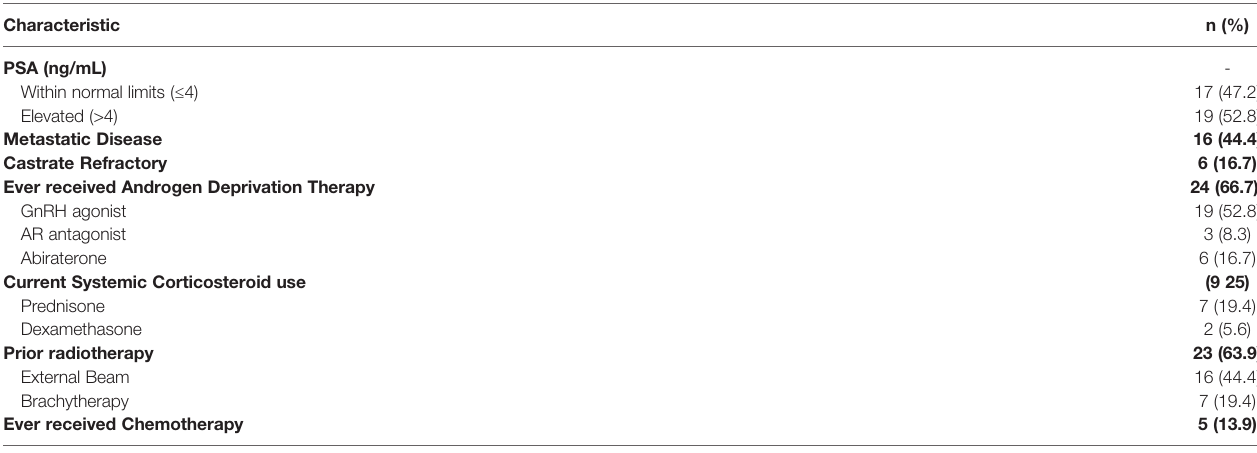
TABLE 1 | Characteristics of participants with prostate cancer. Characteristic